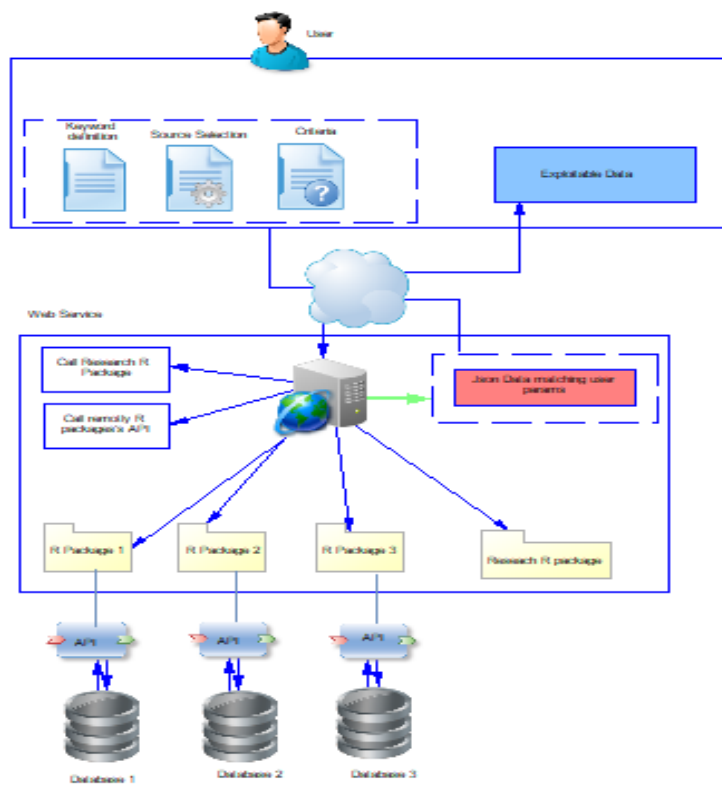
Fig. 4. Process invoking a Web service to get metadata’s